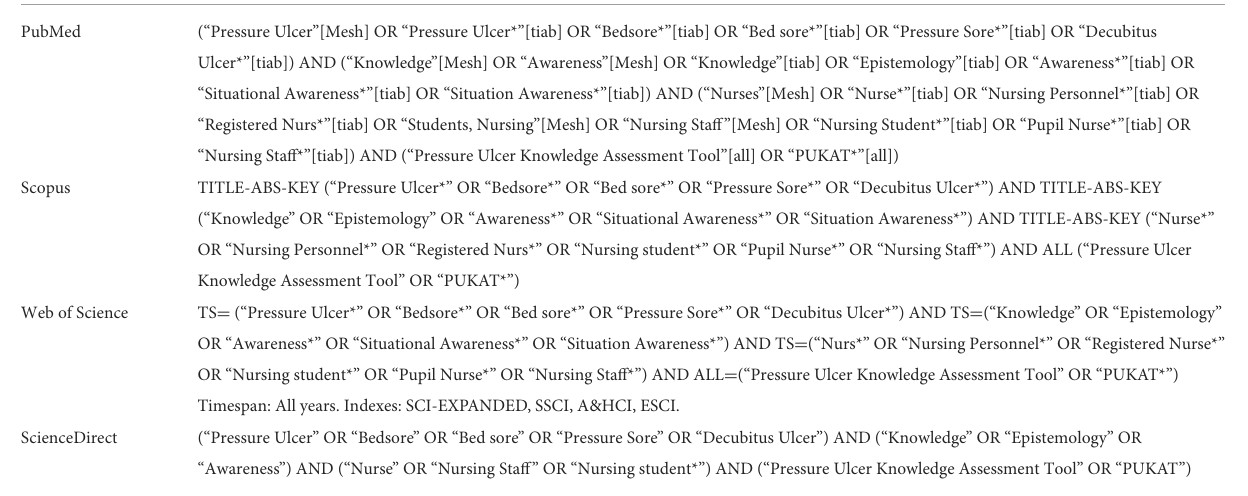
TABLE 1 The result of search